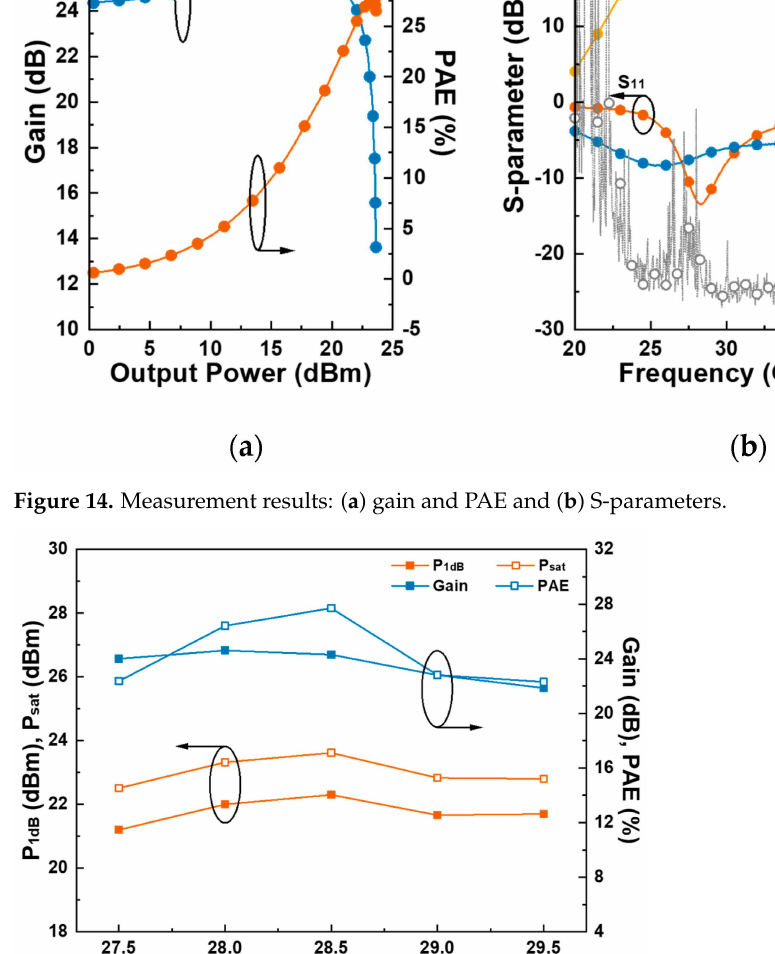
and 9.7 dB peak-to-average power ratio (PAPR) 5G new radio (NR) signal,